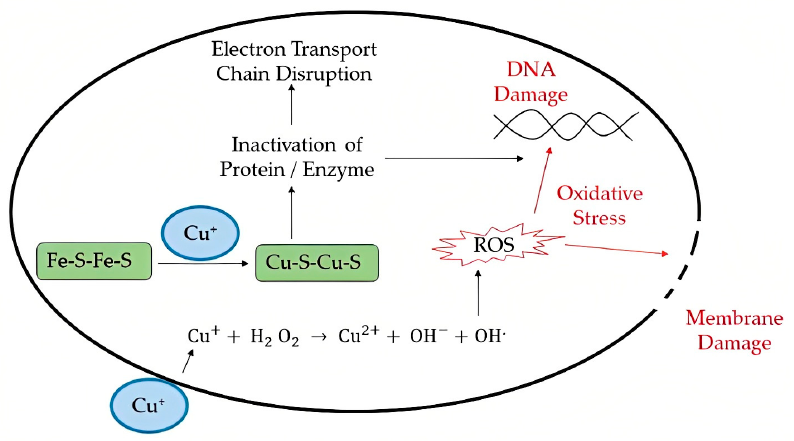
Figure 4. Antiviral mechanism of action of copper ions (reprinted with permission from Nasri et al. [39]).